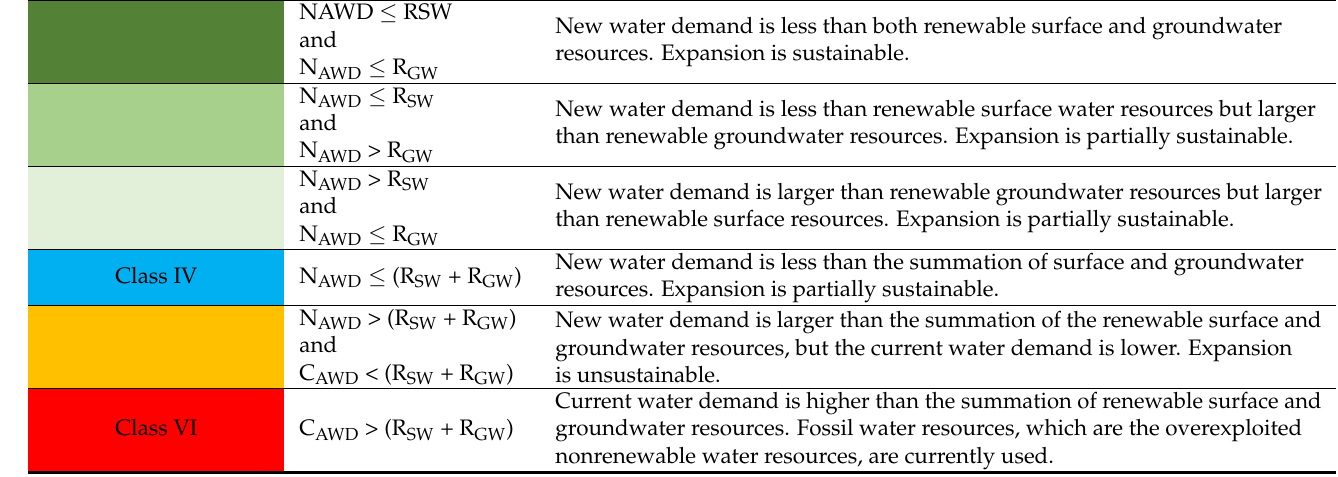
Table 2. Country classification based on the current and new water demand, compared to the renewable surface and groundwater resources